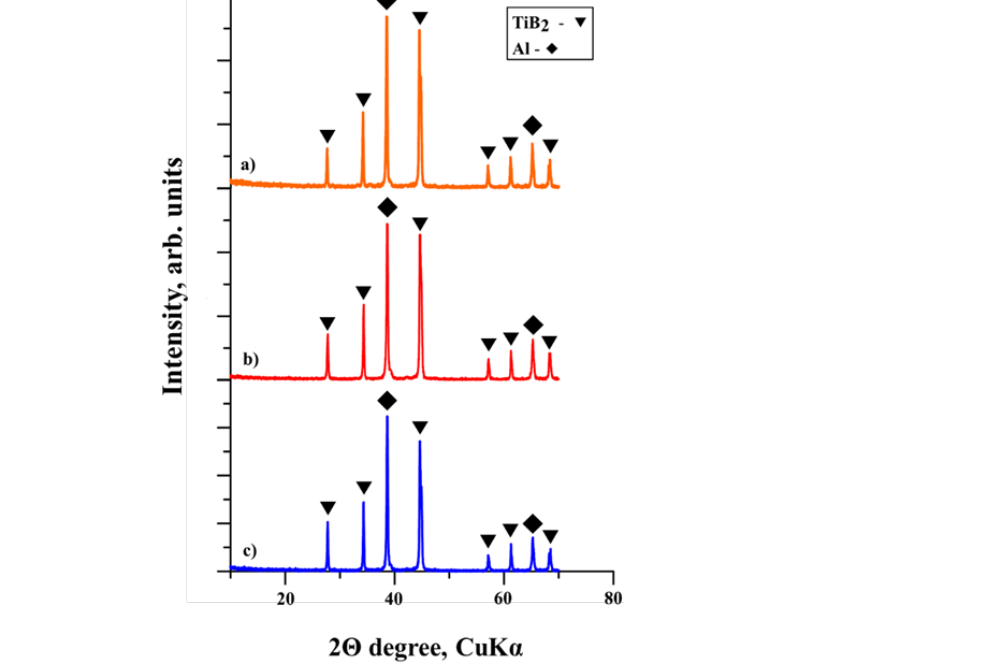
Figure 5. XRD patterns of the SHS products obtained from the Al-Ti-B powder mixture after ( a ) 60 s, ( b ) 180 s, and ( c ) 900 s of mechanical activation. Table 1. XRD results of the SHS products.